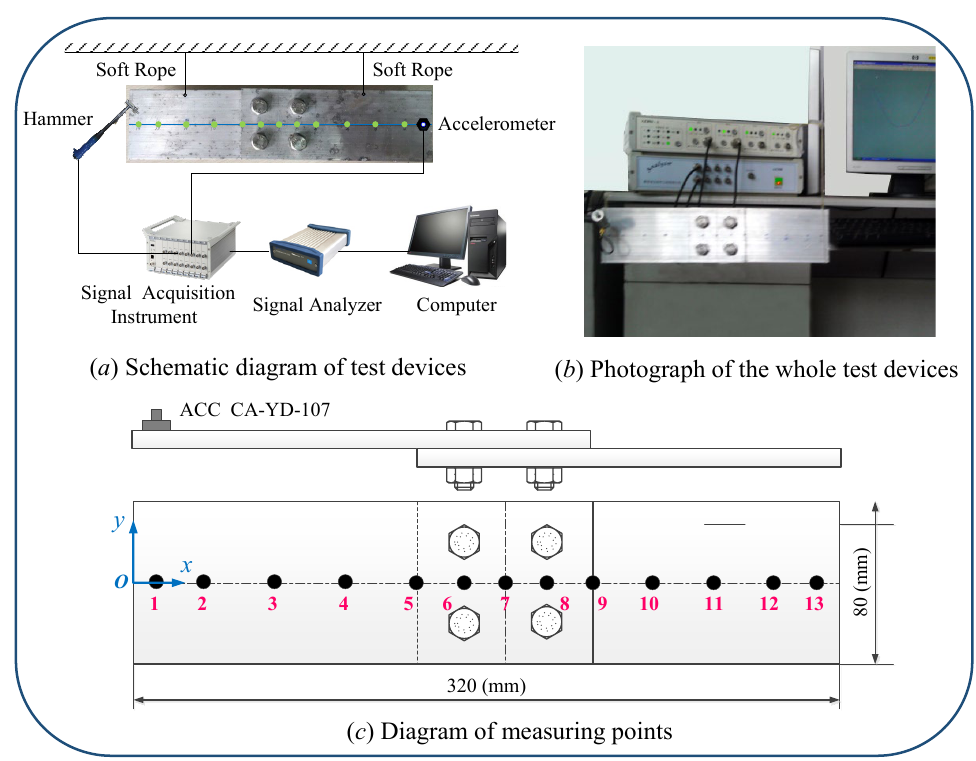
Figure 6. Modal test of the connection structure.